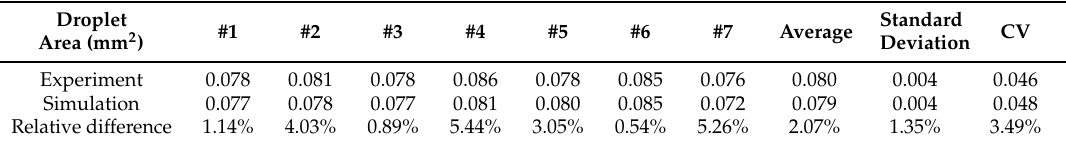
work with exceptions that we are (a) using our new novel compact disc device (see Figure 1b); and (b) switching from sunflower oil to silicon oil (see Table 1). Sunflower oil and silicon oil have almost the same viscosity and density, except that the former possesses higher oil/water interfacial tension of 28.33 mN/m, while the latter has lower oil/water interfacial tension of 14.26 mN/m, which is relatively unfavorable in generating droplets. Silicon oil was chosen not only because it is more widely employed in biomedical applications, but also this allows us to demonstrate the capability of our novel device in generating droplets for oils with lower interfacial tension. In the simulation, the dispersed phase is purged out of the T-junction and moves downstream along the main channel. As the shear force from continuous phase overcomes the interfacial tension of dispersed phase, the latter adopts a thread shape which continuously becomes thinner and eventually breaks up into droplets moving downstream. The generated 3D droplets are illustrated by the green color, as